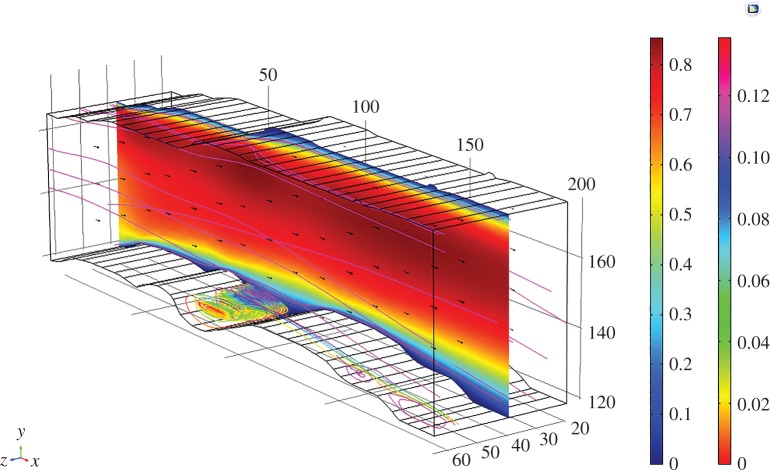
Larger-scale simulation of Sill for an arbitrary thickness (z) of 60 m and single density particles of 3000 kg m−3. Surface (m s−1) velocity magnitude (inner scale bar), particle velocity streamlines (outer scale bar). Note the roll-like geometry of particle orbits in three dimensions. Magma viscosity = 1 Pa s.